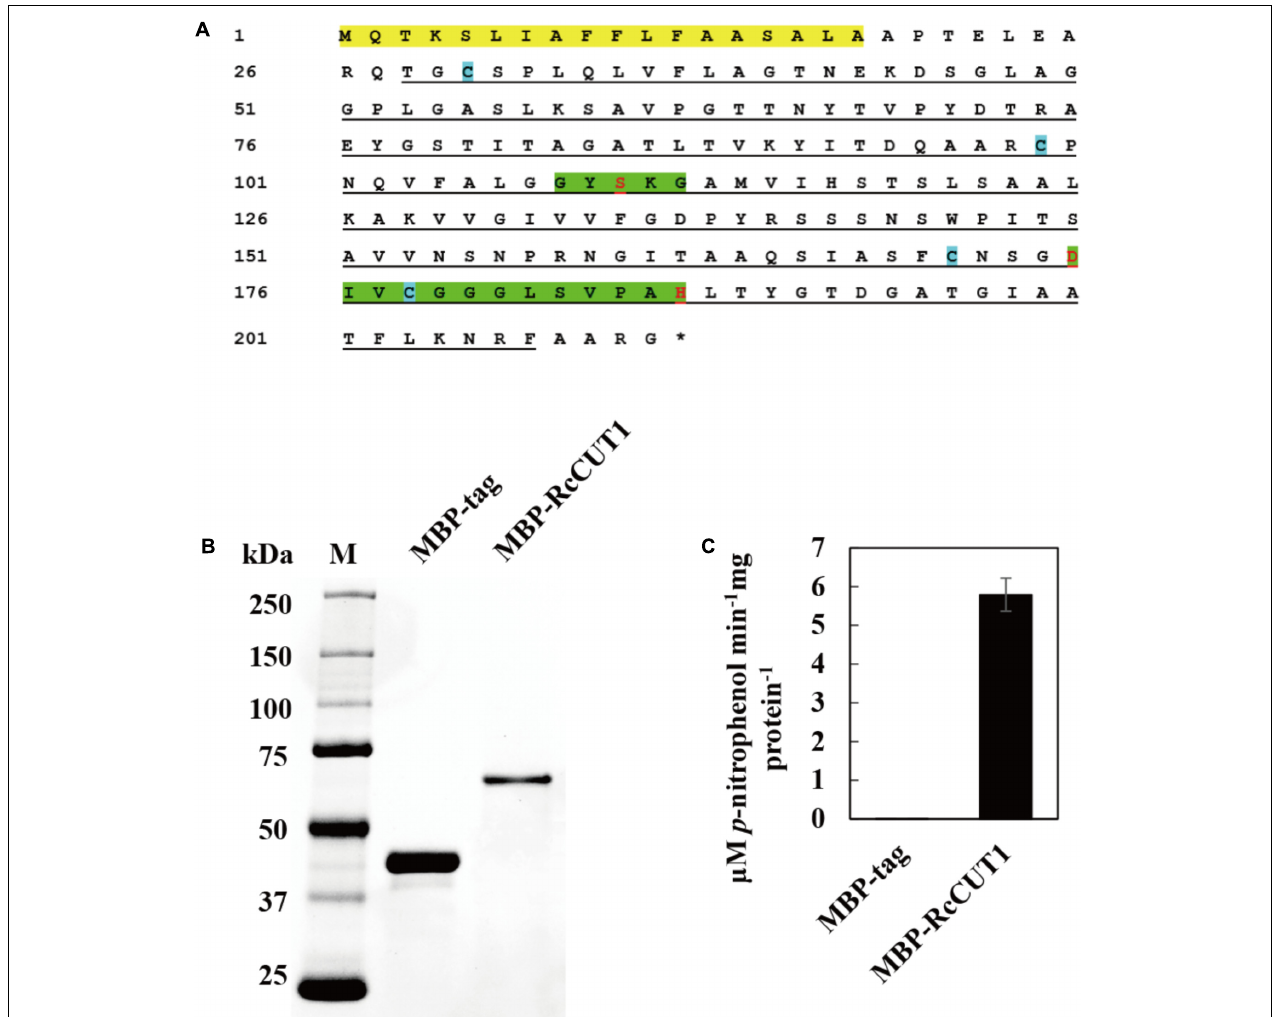
FIGURE 3 | Heterologous expression and cutinase activity of RcCUT1 from Rhizoctonia cerealis . (A) The deduced amino acid sequence of RcCUT1. Yellow part represents signal protein domain, green space indicates the two highly conserved domains of cutinase, the cutinase domain is marked by black lines, and blue cube represents the cysteine. (B) Sodium dodecylsulphate-polyacrylamide gel electrophoresis (SDS-PAGE) of the purified enzymes of RcCUT1 from R. cerealis . (C) Enzyme activity of RcCUT1 was measured at 20 ◦ C using p -NPB as substrate. Standard errors are